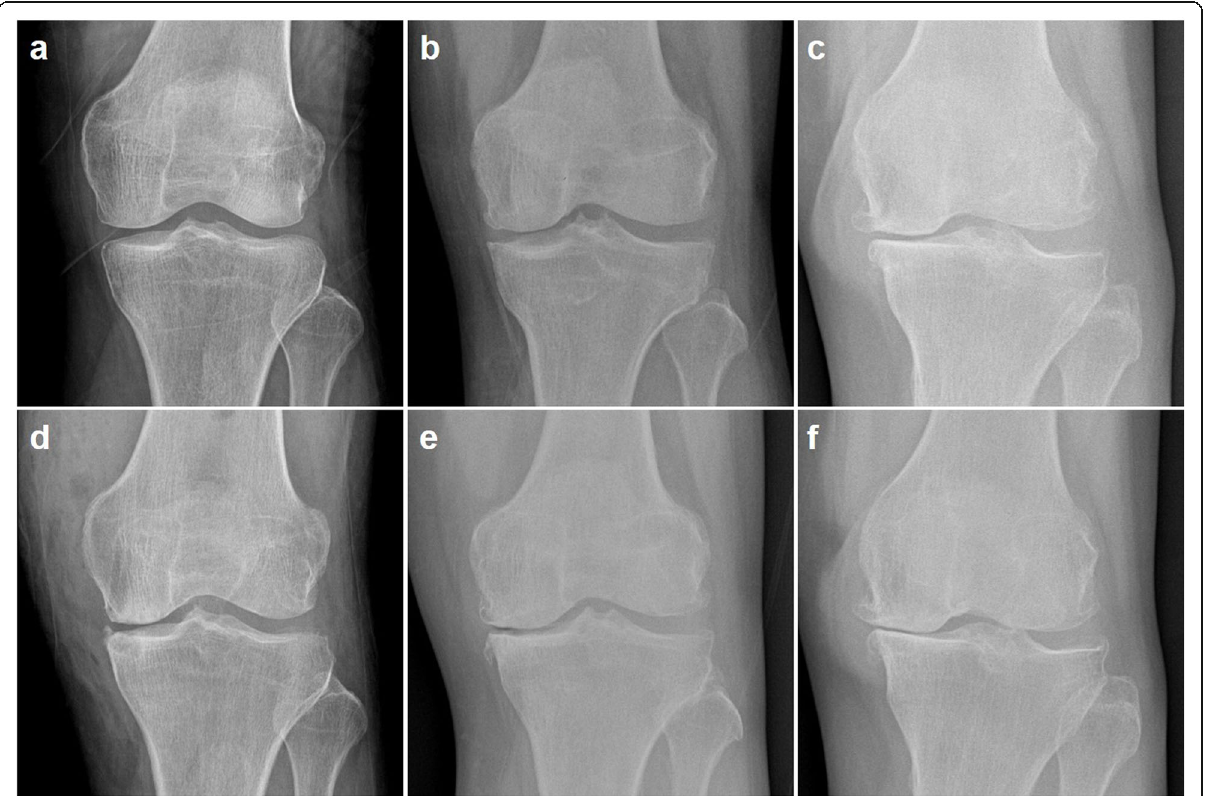
Fig. 4 Radiographs showing the weight-bearing anterior-posterior (AP) views at baseline ( a – c ) and 1 year after injection ( d – f ). Radiographs of a 59-year-old man revealing a progression of knee osteoarthritis (OA) from Kellgren-Lawrence (K-L) grade 1 at baseline ( a ) to K-L grade 2 at 1 year after hyaluronic acid (HA) injection ( d ). Radiographs of a 64-year-old woman demonstrating an advancement of knee OA from K-L grade 2 at baseline ( b ) to K-L grade 3 at 1 year after mesenchymal stem cell (MSC) injection ( e ). Radiographs of a 62-year-old woman depicting a deterioration of knee OA from K-L grade 3 at baseline ( c ) deteriorating to K-L grade 4 at 1 year after HA injection ( f